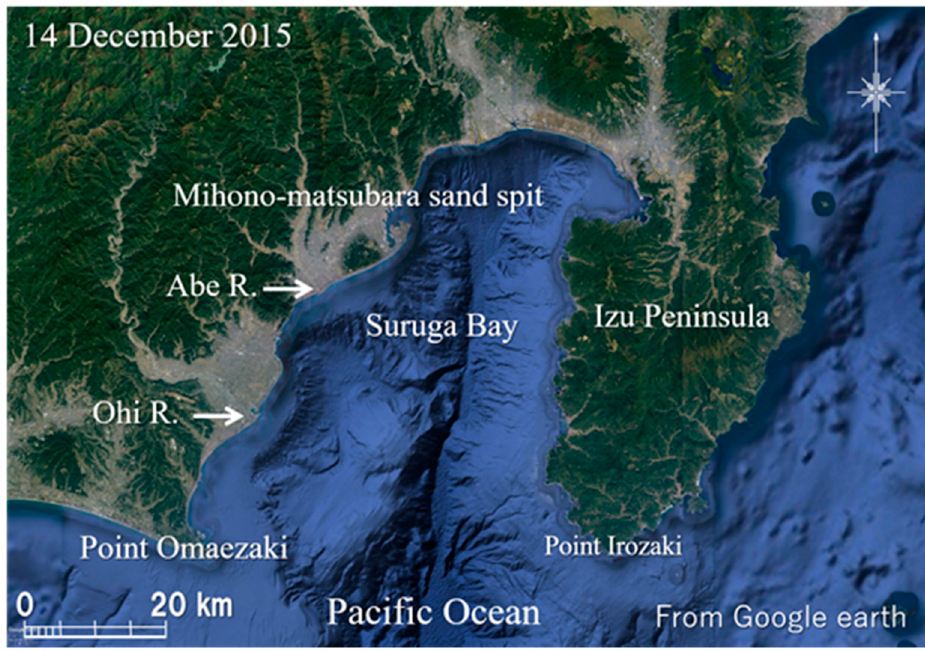
Figure 29. Satellite image of Suruga Bay (for location, 34°36 ′ 16.73 ′ ’ N, 138°16 ′ 50.47 ′ ’ E).